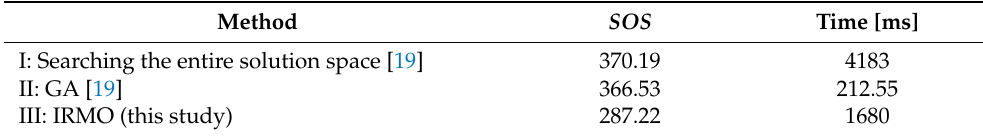
Table 3. Comparison of optimal fitting results.